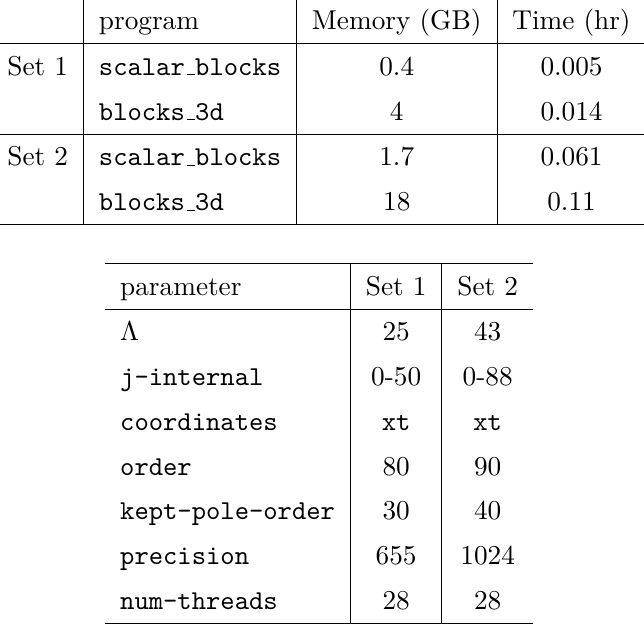
Table 1 : Memory usage and total runtime for two sets of parameters for scalar blocks and blocks 3d , averaged over 10 runs